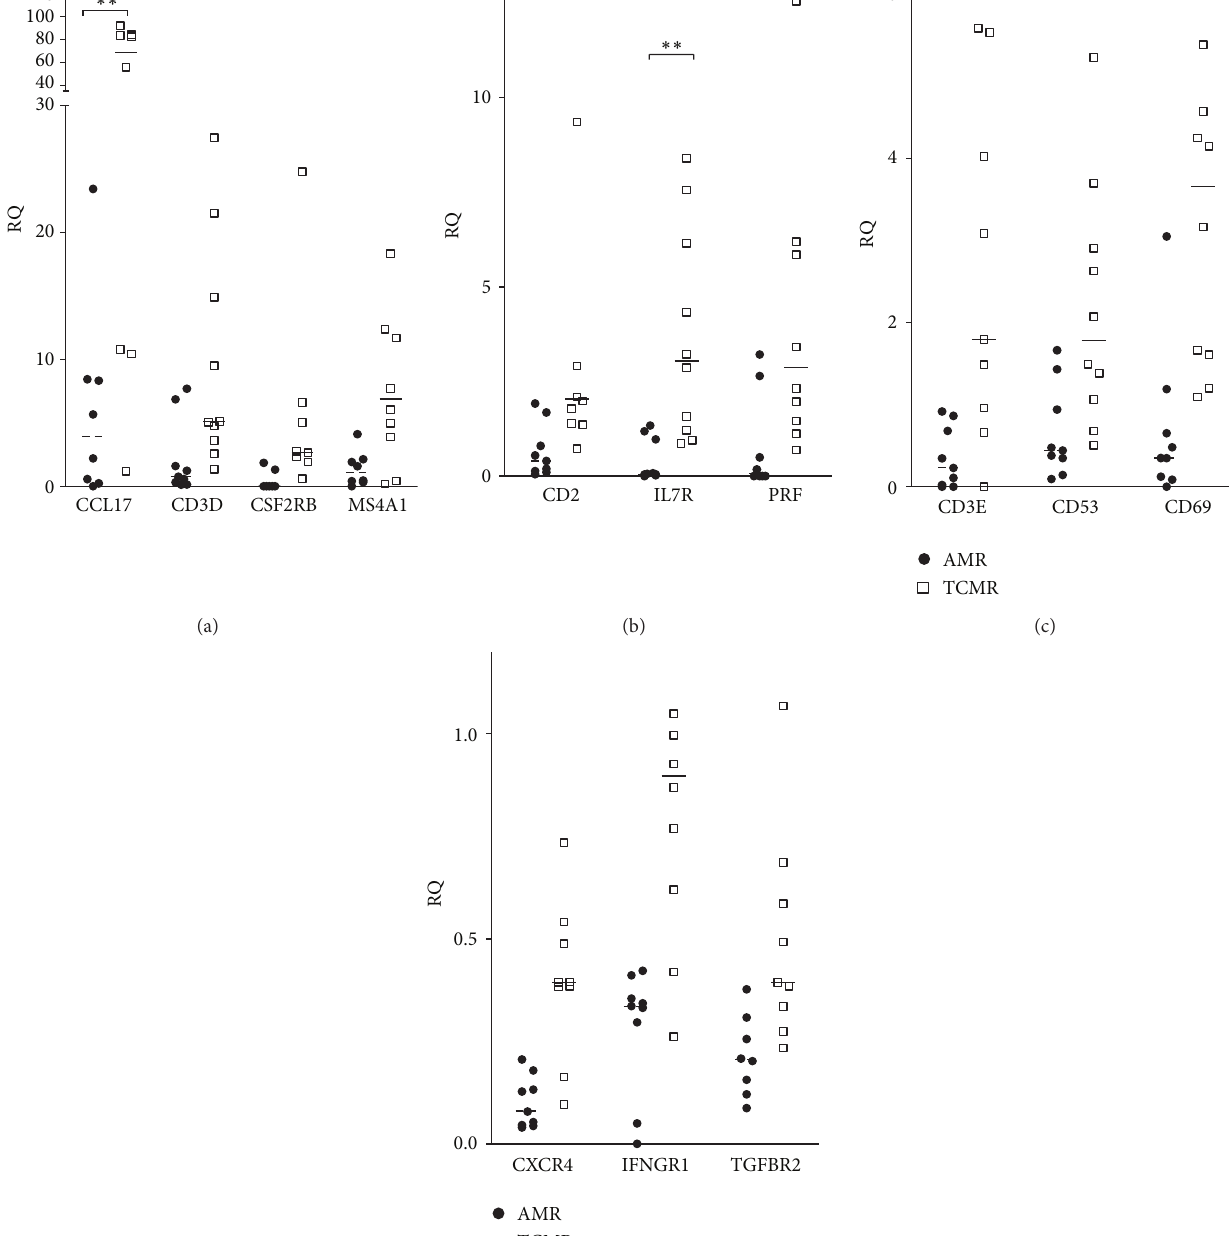
Figure 2: Genes differentially expressed between AMR and TCMR. Lines show medians of RQ. ∗∗ 𝑃 < 0.01 ; all unmarked plots: 𝑃 < 0.05